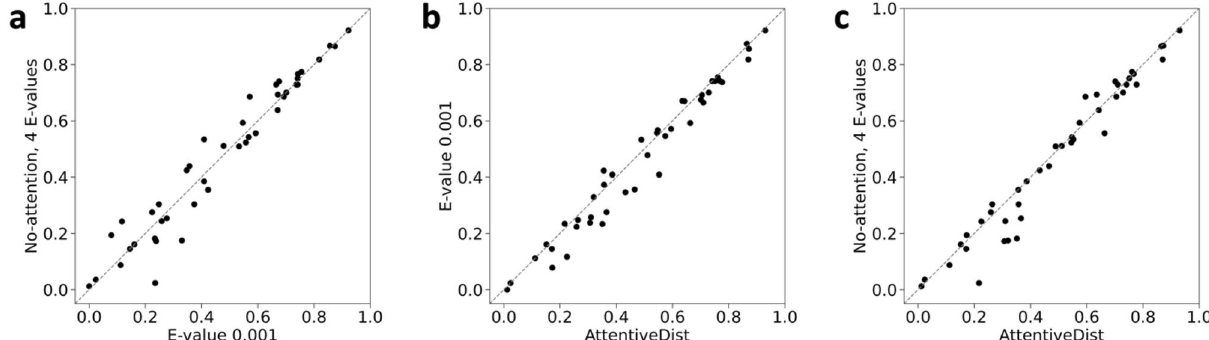
Figure 3. Individual target L/1 precision comparison between ( a ), 4 E-value model without attention and E-value 0.001 model ( b ) E-value 0.001 model and AttentiveDist c, 4 E-value model without attention and AttentiveDist. E-value 0.001 model represents the model trained with E-value 0.001 MSA features in multi-task